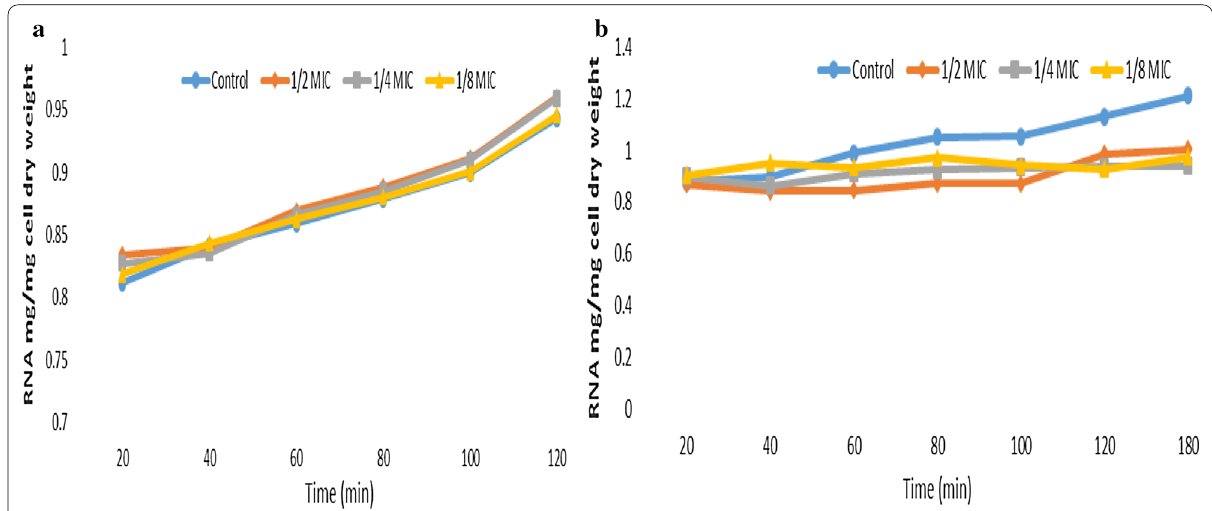
Fig. 4 Effect of different Citrus lemon leaves oil on the RNA biosynthesis in cells of P. aeruginosa ( a ), S. aureus ( b )